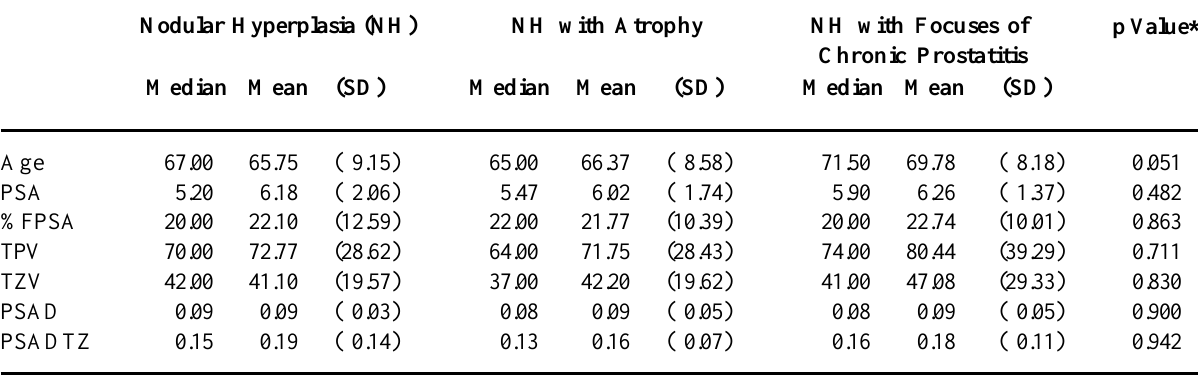
Table 1 – Median, mean, standard deviation (SD) and comparisons among 3 groups of patients presenting benign alterations of the prostate in relation to age (years), serum concentration of PSA(ng/mL), %FPSA (%), TPV (cc), TZV